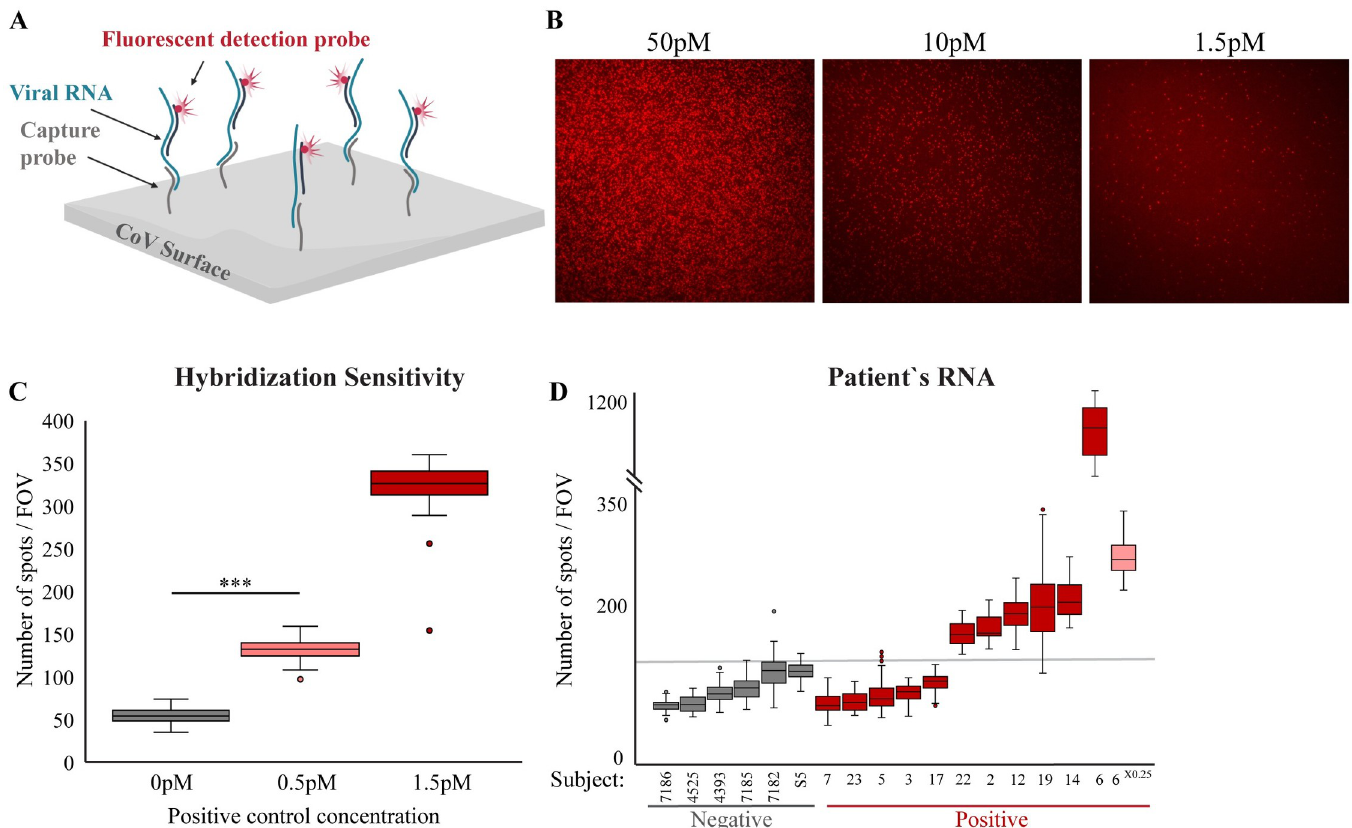
Fig 1. Single-molecule enzyme-free detection of SARS-CoV-2 genetic material. (A) Scheme of the genetic diagnostic test. Viral RNA is incubated with complementary DNA probes that are labeled with either biotin (capture probes) or fluorophore (detection probe). Following incubation, samples are loaded on a streptavidin-coated coverslip and imaged with TIRF microscopy. (B) Raw TIRF field of view (FOV) images of titration of positive control DNA at the indicated concentrations. (C) Quantitative and sensitive detection of hybridization complexes. Synthetic DNA controls (in the concentrations indicted in the x-axis labels) was analyzed as in B and the fluorescent signal quantified. Box plot shows the number of spots per FOV for all the FOV imaged for each sample in this experiment. For background assessment, capture and detection probes were incubated with no synthetic DNA. ��� p-value < 0.001. (D) RNA extracted from swab samples obtained from two medical facilities (samples numbers are noted on the x-axis) was analyzed as described in A. Box plot shows the number of spots per FOV for all the FOV imaged for each sample in this experiment. The highly positive sample (sample #6) was analyzed both at 1X (dark red) and 0.25X (pink) concentration. Group statistics: all negative samples: mean 91.3, Coefficient of Variation (CV) 0.2; all positive samples: mean 218.8, CV